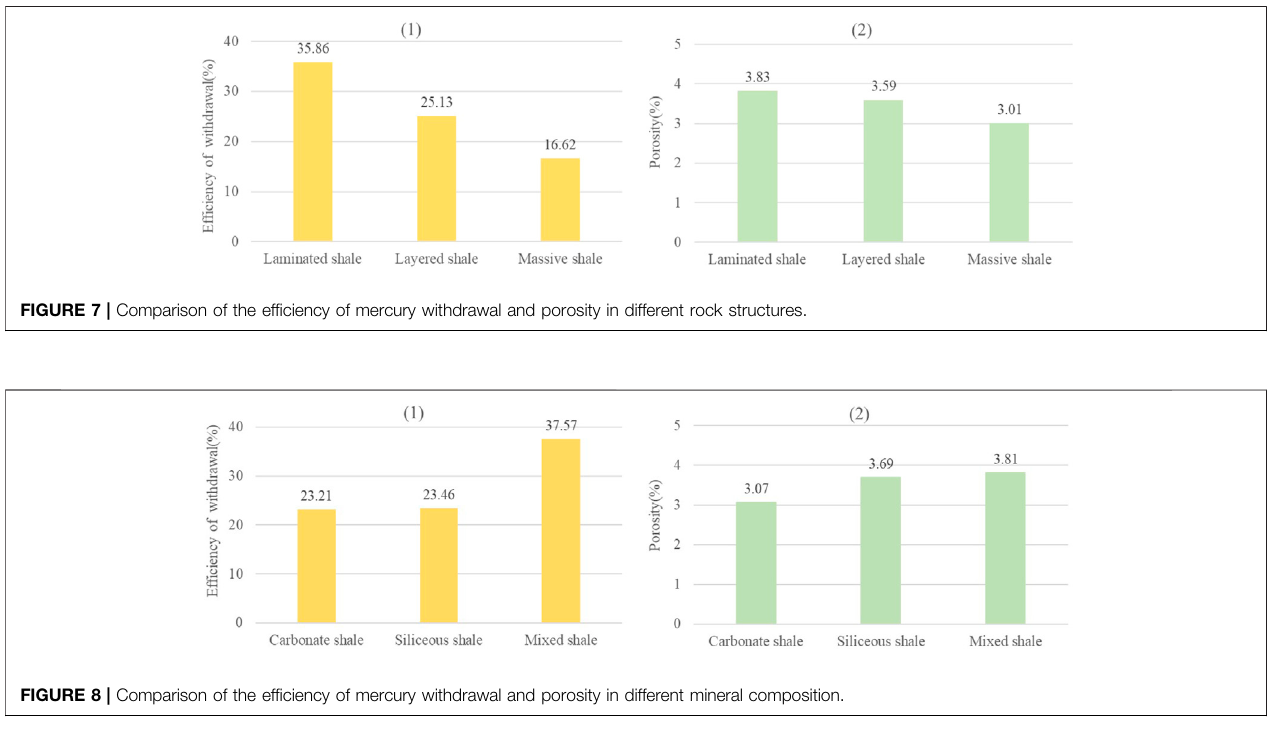
Frontiers in Earth Science |